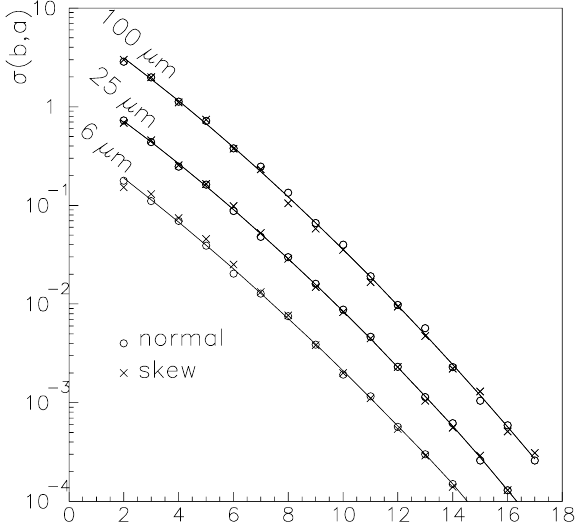
FIG. 10. Numerical estimate (markers) and parabolic fit (solid line) of the geometric random multipoles due to random block displacements of different amplitudes d for the five-block coil of the main LHC dipole.